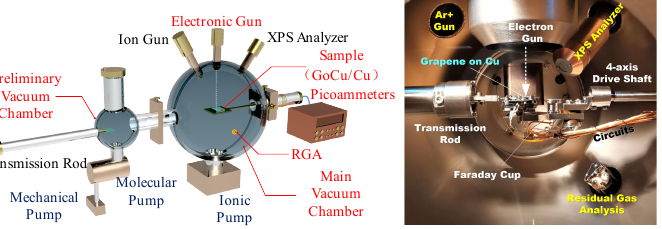
Figure 7. Secondary electron emission and electron stimulated desorption measurement setup: Structure diagram ( left ) and interior view ( right ).